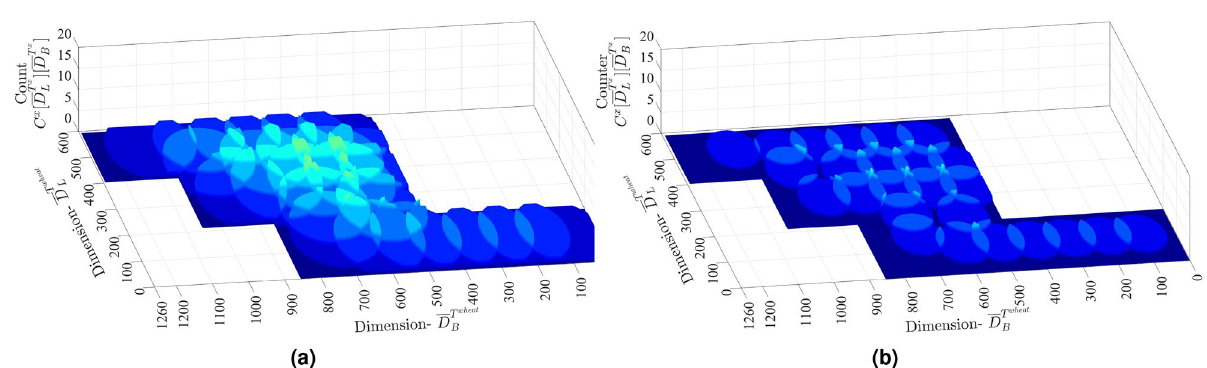
T x ][ D T x ] for x = wheat in sowing an maturity stage for GBA. MATLAB 2016a. https:// in. L B